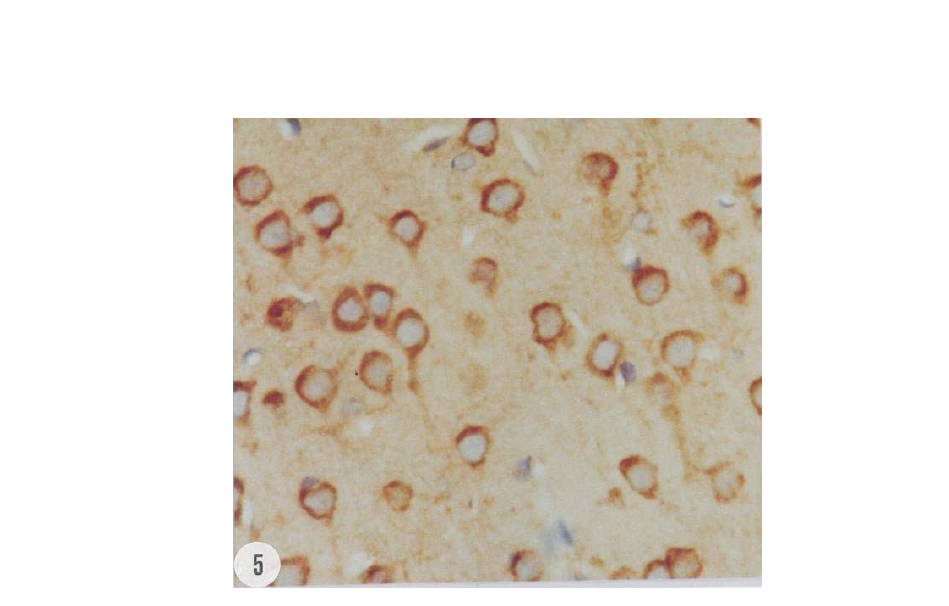
Figure 5. Strong NSE immunoexpression in neurons 72 hr after low dose envenoming. (X400)